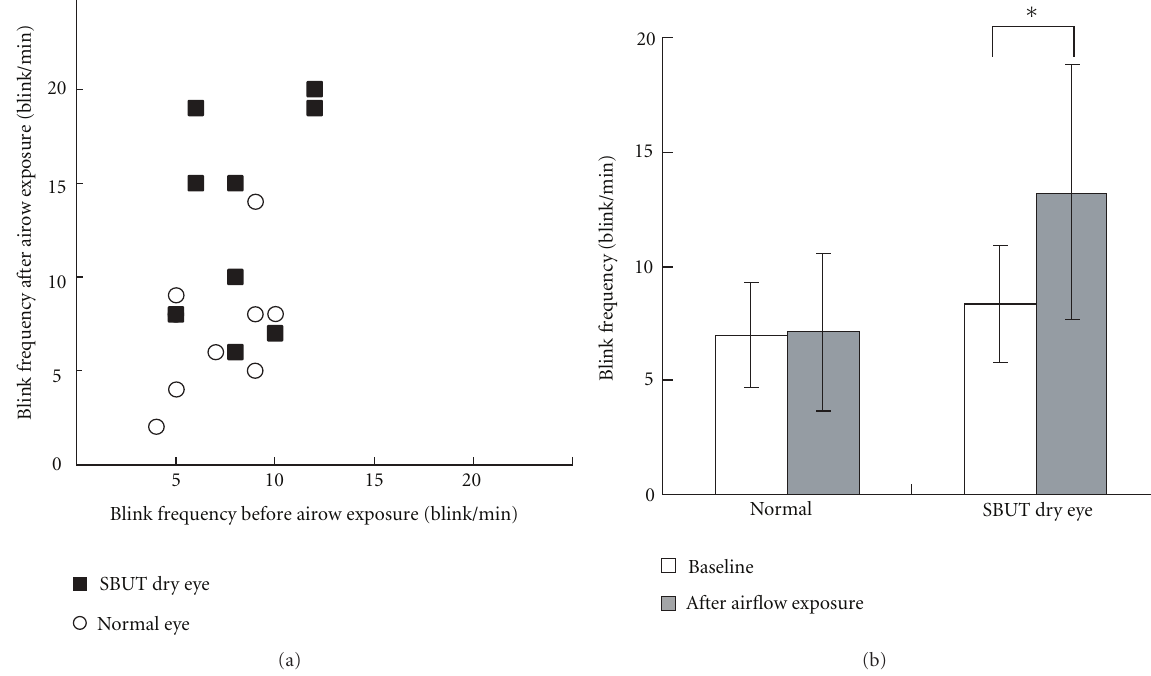
Figure 3: (a) Airflow-exposure-induced changes in blink frequencies are presented for normal and short tear film breakup time dry eye (SBUT dry eye) groups. (b) Changes in blink frequencies before and after airflow exposure are shown. Blink frequency increased significantly in SBUT dry eyes ( P = 0 . 039, Wilcoxon signed-rank test), while there was no significant change in the blink frequencies of normal eyes. SBUT dry eye: short tear film breakup time dry